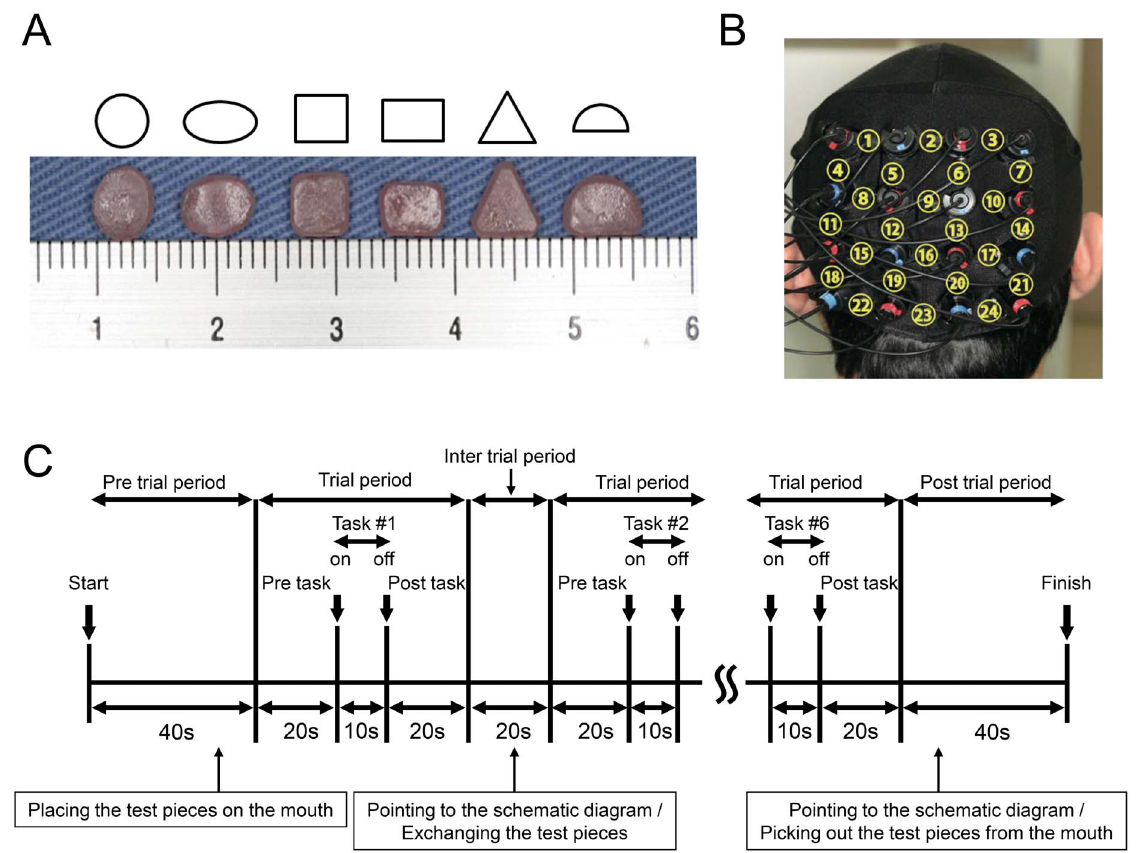
Figure 1. Experimental design and positions of near-infrared spectroscopy (NIRS) probes. A: Photograph and schematic diagram of the test pieces (circle, ellipse, square, rectangle, triangle, semicircle) used for shape discrimination by the mouth (oral shape discrimination; SHAPE). B: Position of NIRS probes and corresponding channel numbers. C: Timeline of a single session, which was composed of 6 trials. Prior to the session, subjects were shown the test pieces and a schematic diagram of the test pieces, received an explanation of the procedure, and were allowed to rehearse the task. During the SHAPE trials, a test piece was placed on the tongue of the subject. The subject was instructed to take this into their mouth and remain quiet until receiving a verbal cue (pre-trial period). At the verbal cue, the subject was instructed to explore the test piece in their mouth without biting (task period, 10 seconds). After 10 seconds, another verbal cue was given and the subject was instructed to remain quiet for 20 seconds (post-task period). Next, the subject was shown a schematic diagram of the 6 test pieces and asked to point to their answer after the test piece was removed from the mouth during the inter-trial and post-trial periods. Each trial was performed a total of 6 times, once for each shape. During the SHAM trials, the subjects performed the same protocol but without the test